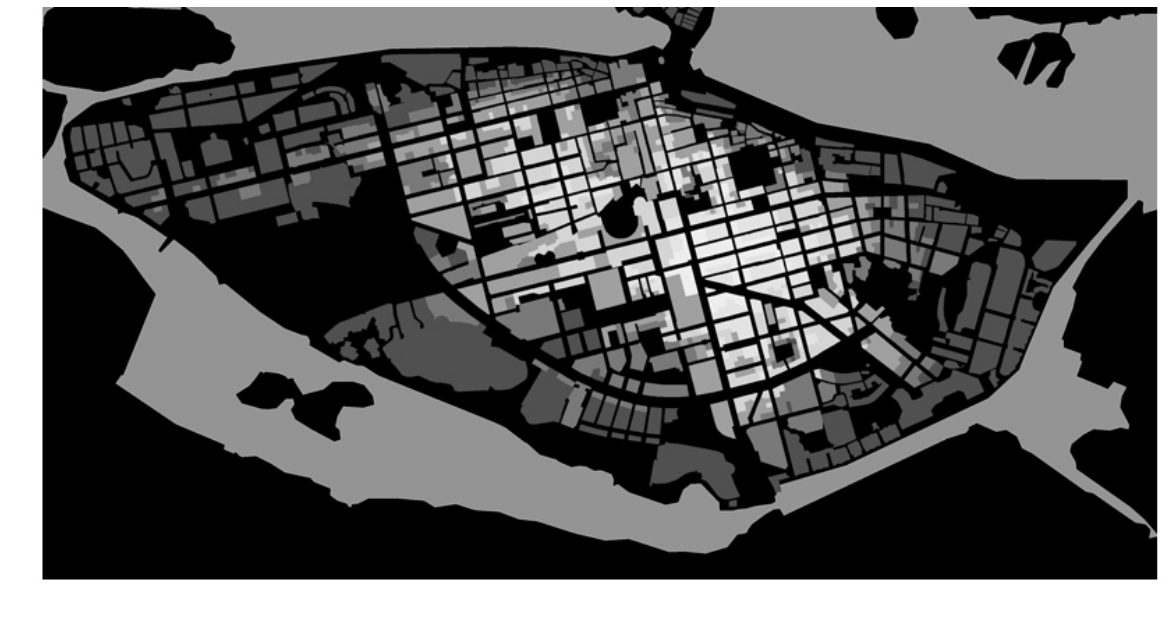
Fig. 5 . Variations in accessibility to built floor space within 1000 m, following the street network, calculated from each parcel (light grey represents high accessibility and dark grey